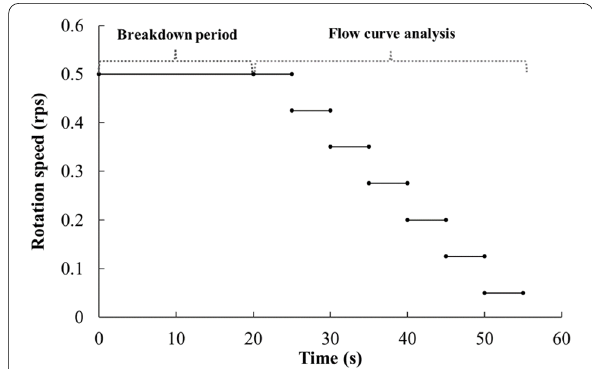
Fig. 6 Rheological shearing